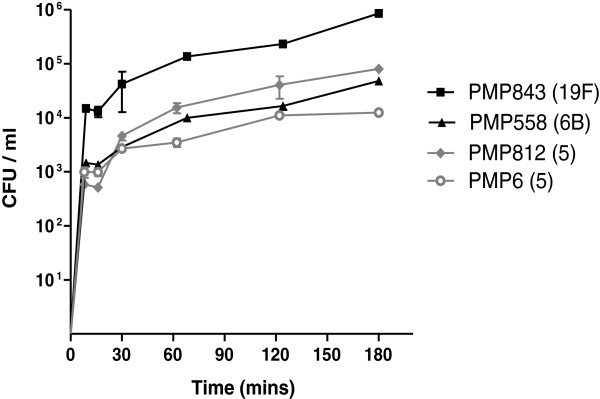
Time-course of pneumococcal adherence to epithelial cells. Cells were inoculated with 7.2 x 105 CFU (95%CI 5.8 x 105, 8.7 × 105 CFU) and the number of adherent pneumococci measured over three hours. Mean ± SD for four pneumococcal isolates are depicted (n=2).